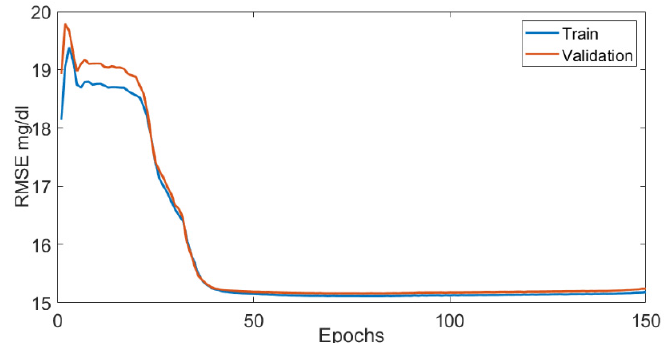
Figure 5. The RMSE results of the proposed model in different epochs.